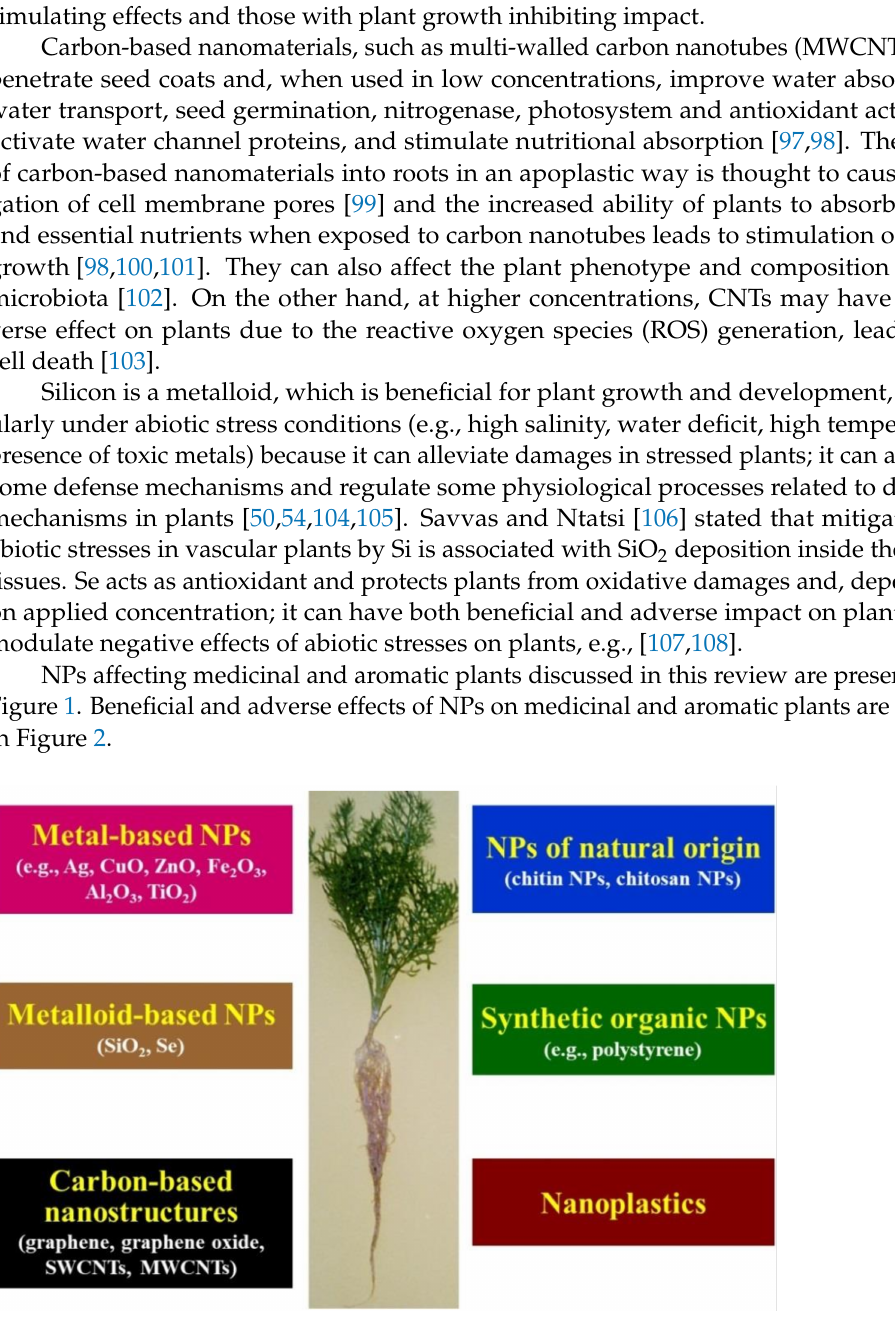
Figure 1. Types of nanoparticles (NPs) affecting medicinal and aromatic plants discussed in this